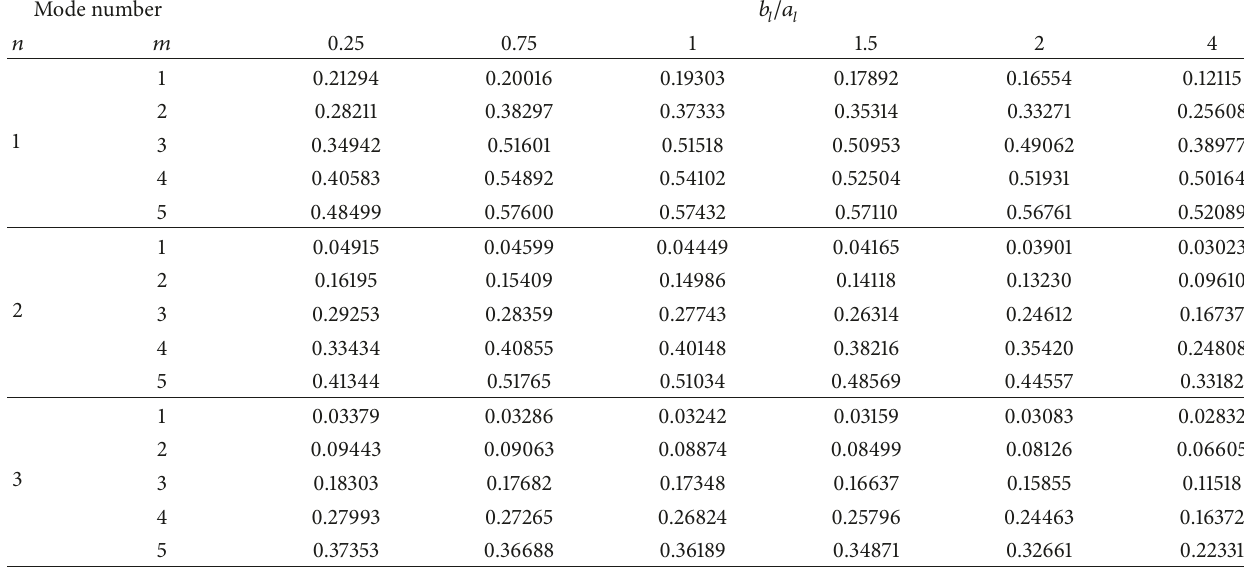
Table 3: The frequency parameters Ω of the ECE vessel.